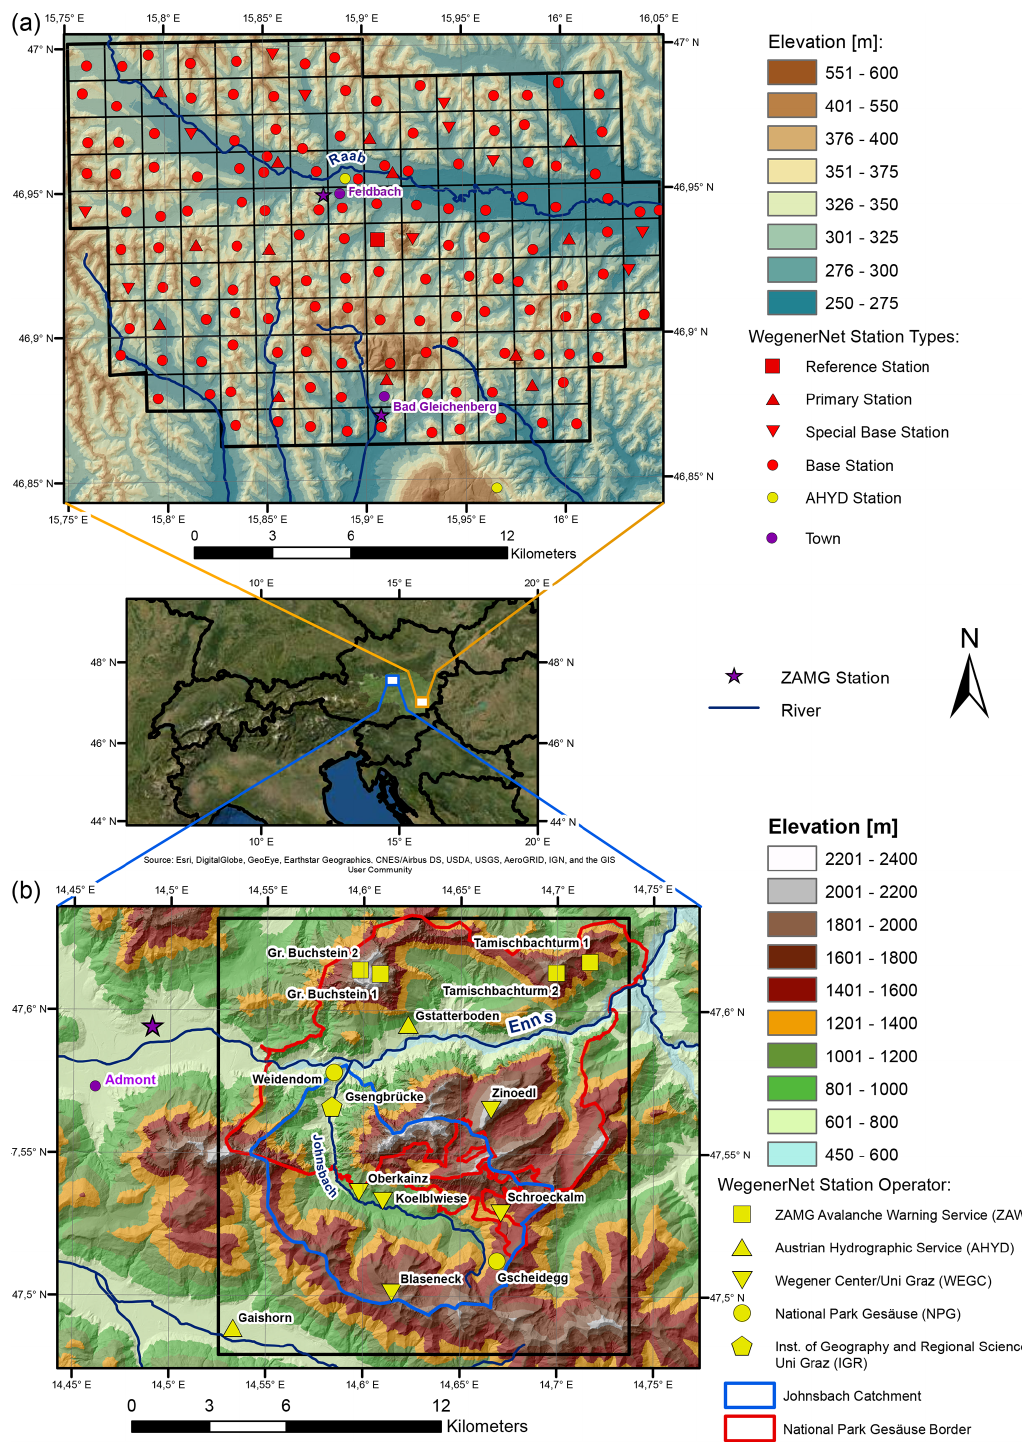
Figure 1. Overview of the study areas: (a) the WegenerNet Feldbach Region (FBR) in the southeast of Styria, Austria, with a core region (thick black polygon) of about 22km × 16km and 155 meteorological stations and (b) the WegenerNet Johnsbachtal (JBT) in the north of Styria, Austria, with a core area (black rectangle) of about 16km × 17km and 14 stations. The middle panel shows their location in the greater Alpine region (WegenerNet FBR: orange rectangle; WegenerNet JBT: blue rectangle). The legend on the right explains map characteristics, WegenerNet FBR station types (as defined in Table 1), and WegenerNet JBT station operators.